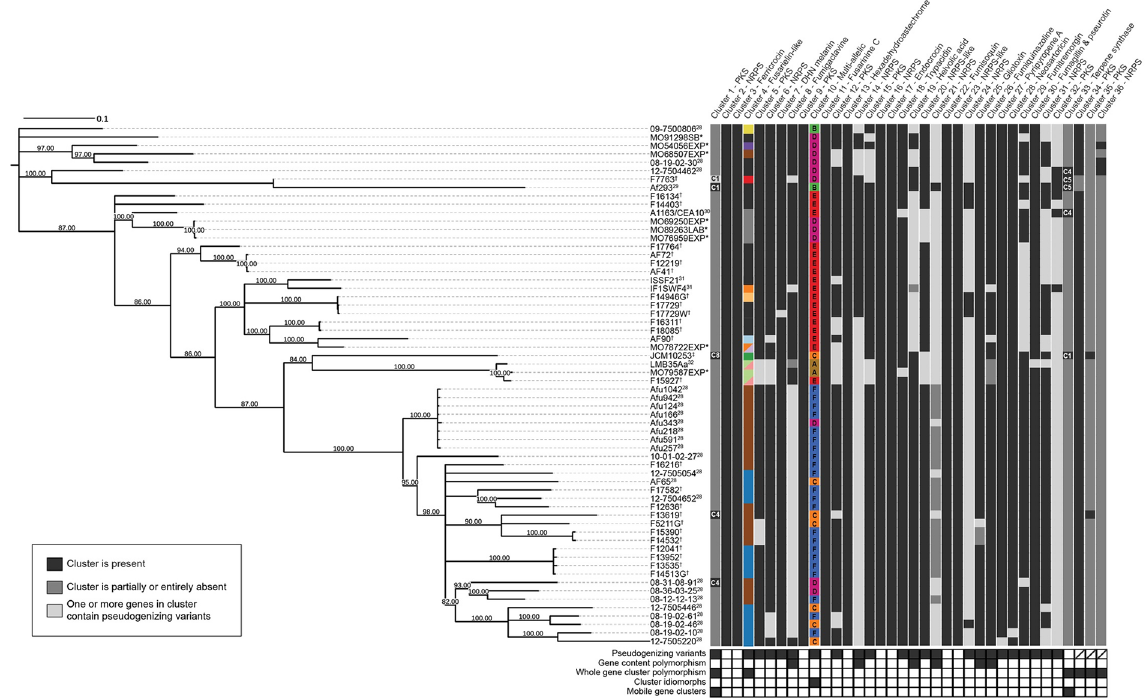
Fig 1. Genetic diversity of secondary metabolic gene clusters within a fungal species. The phylogeny was constructed using 15,274biallelic SNPs with no missing data. The tree is midpoint rooted and all branches with bootstrap support less than 80% are collapsed. This phylogenydoes not includestrains Af10, Af210, Z5, or RP-2014, as short-readdata were not available. Superfixes followingstrain names indicatepublicationsassociated with DNA sequencing. * indicatesstrains sequencedin this study, † indicatesstrains sequencedat JCVI with no associatedpublication, and ‡ indicatesstrains sequencedby Rikenwithno associated publication. Heat maps show presence, absence,and polymorphisms in SM gene clusters. Black indicatesthe cluster is present in a strain with no polymorphisms, aside from missense variants, light gray indicates1 or more genesin the cluster are pseudogenized, and dark gray indicatesthe cluster is partially or entirely absent (see Fig 2). Colors for cluster 4 indicate which pseudogenizing variants are present (see Fig 3) and colors for cluster 10 indicatewhich alleleof the cluster is present (see Fig 4). Chromosomal locationof clusters 1 and 33 are indicated. If more than one type of polymorphism is present within a cluster in a strain, only 1 is depicted.Types of polymorphisms found in each cluster are summarized belowthe cluster heat map. DHN, dihydroxynaphthalene; JCVI, J. Craig Venter Institute; NRPS, nonribosomal peptidesynthase; PKS, polyketidesynthase; SM, secondary metabolite; SNP,